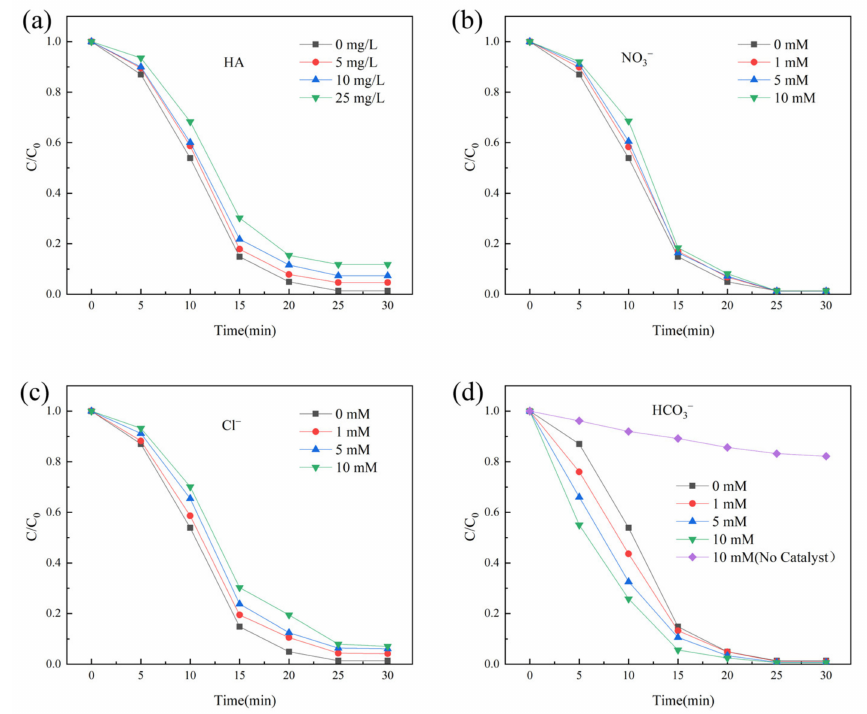
Figure 10. The effects of ( a ) HA, ( b ) NO 3 − , ( c ) Cl − , and ( d ) HCO 3 − on CQP degradation in the CoFe 2 O 4 @CNTs/PMS system. (Experimental conditions: [[CQP] 0 = 10 mg/L, catalyst = 35 mg/L, PMS = 2.0 mM, initial pH = 6.5 ± 0.3, T = 25 ◦ C.).